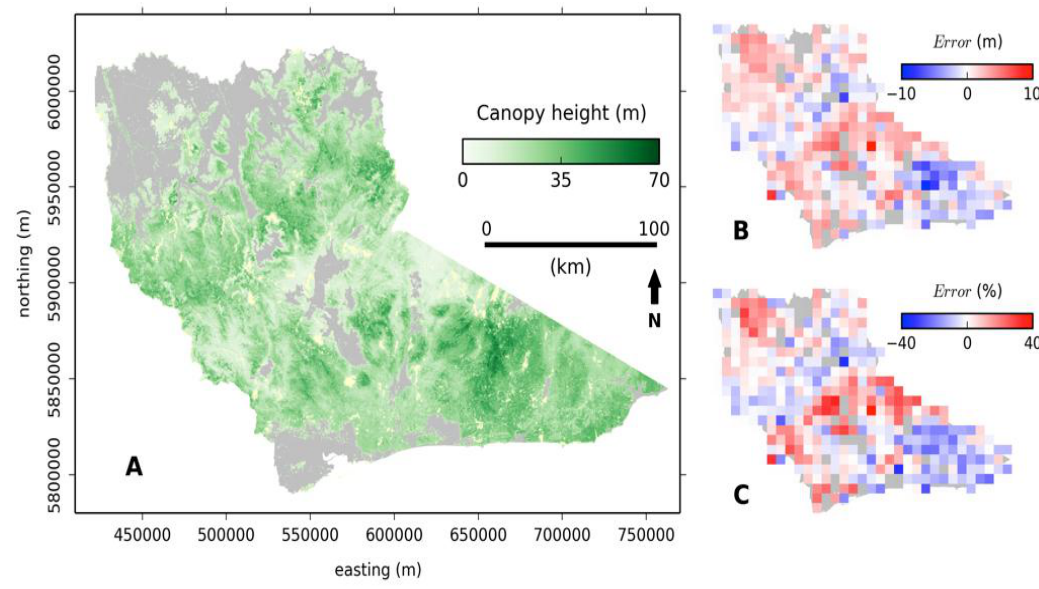
Figure 5. Canopy height at a 30 m resolution (clipped to forest extent) generated using random forest − systematic error ( A ). Model output when compared to ALS derived canopy height (10 km × 10 km resolution) where error is represented as height difference ( B ) and percentage of height ( C ). Coordinate system is the projected Map Grid of Australia (MGA) zone